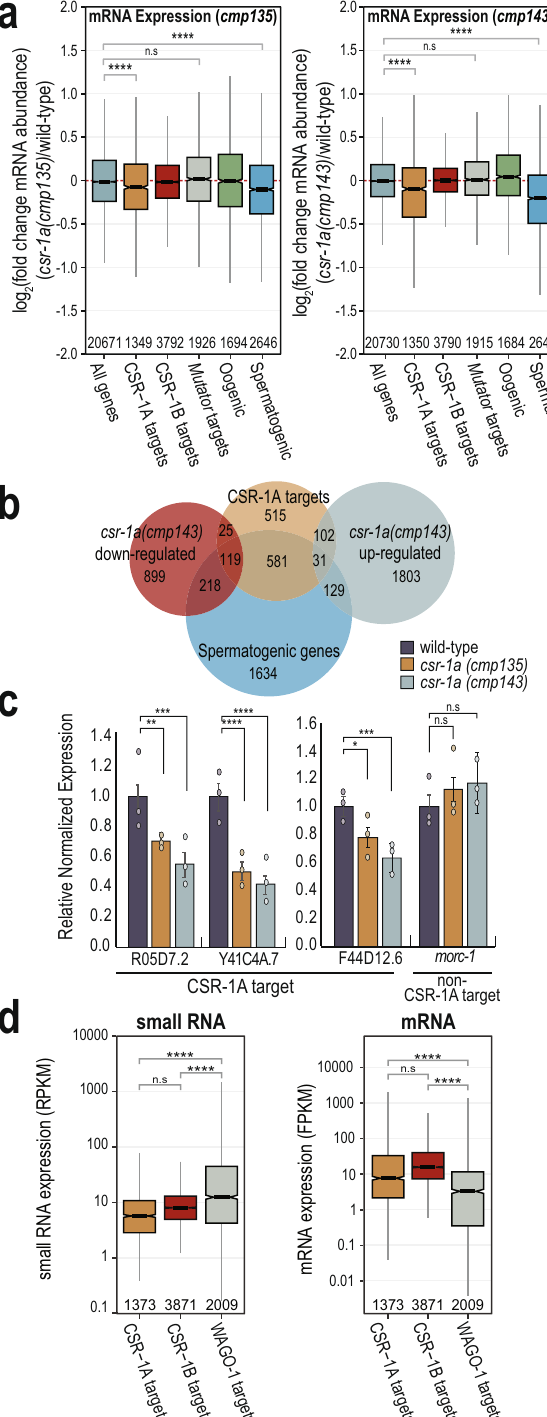
small RNAs in the CSR-1A immunoprecipitation. We determined that all three genes showed a consistent and signi fi cant decrease in transcript levels in both csr-1a mutants compared to wild-type animals (Fig. 5c). In contrast, the csr-1a mutants had no effect on morc-1 , a germline gene that was only enriched in CSR-1B and CSR1A + B immunoprecipitation, and not in CSR-1A (Fig. 5c). Therefore, CSR-1A appears to have modest but signi fi cant posi- tive effects on some of its target transcripts, such that in its absence, these genes have reduced